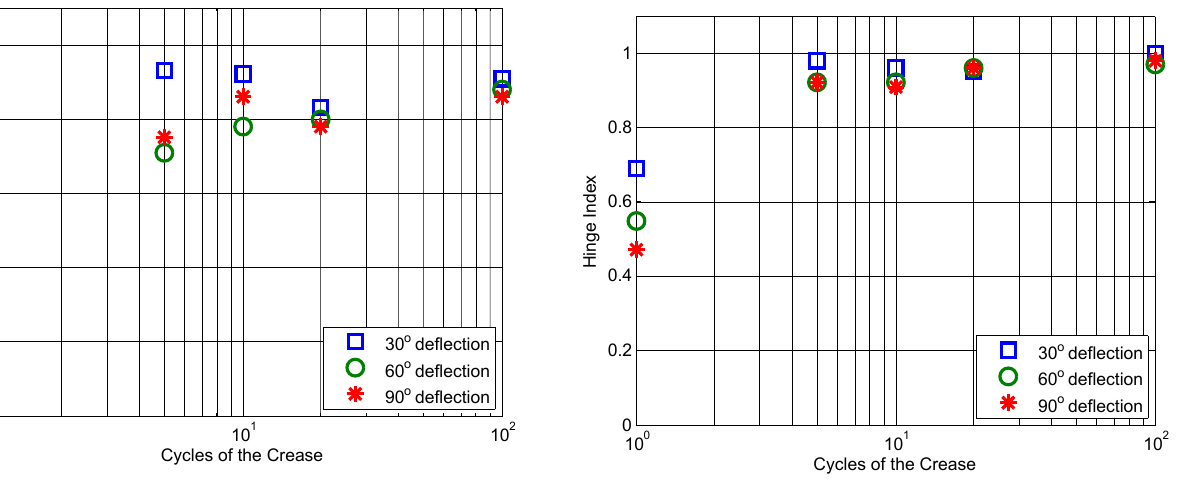
Figure 12. Tyvek ® (0.25mm thick): hinge index verses cycles of the crease. A strong asymptotic behavior is